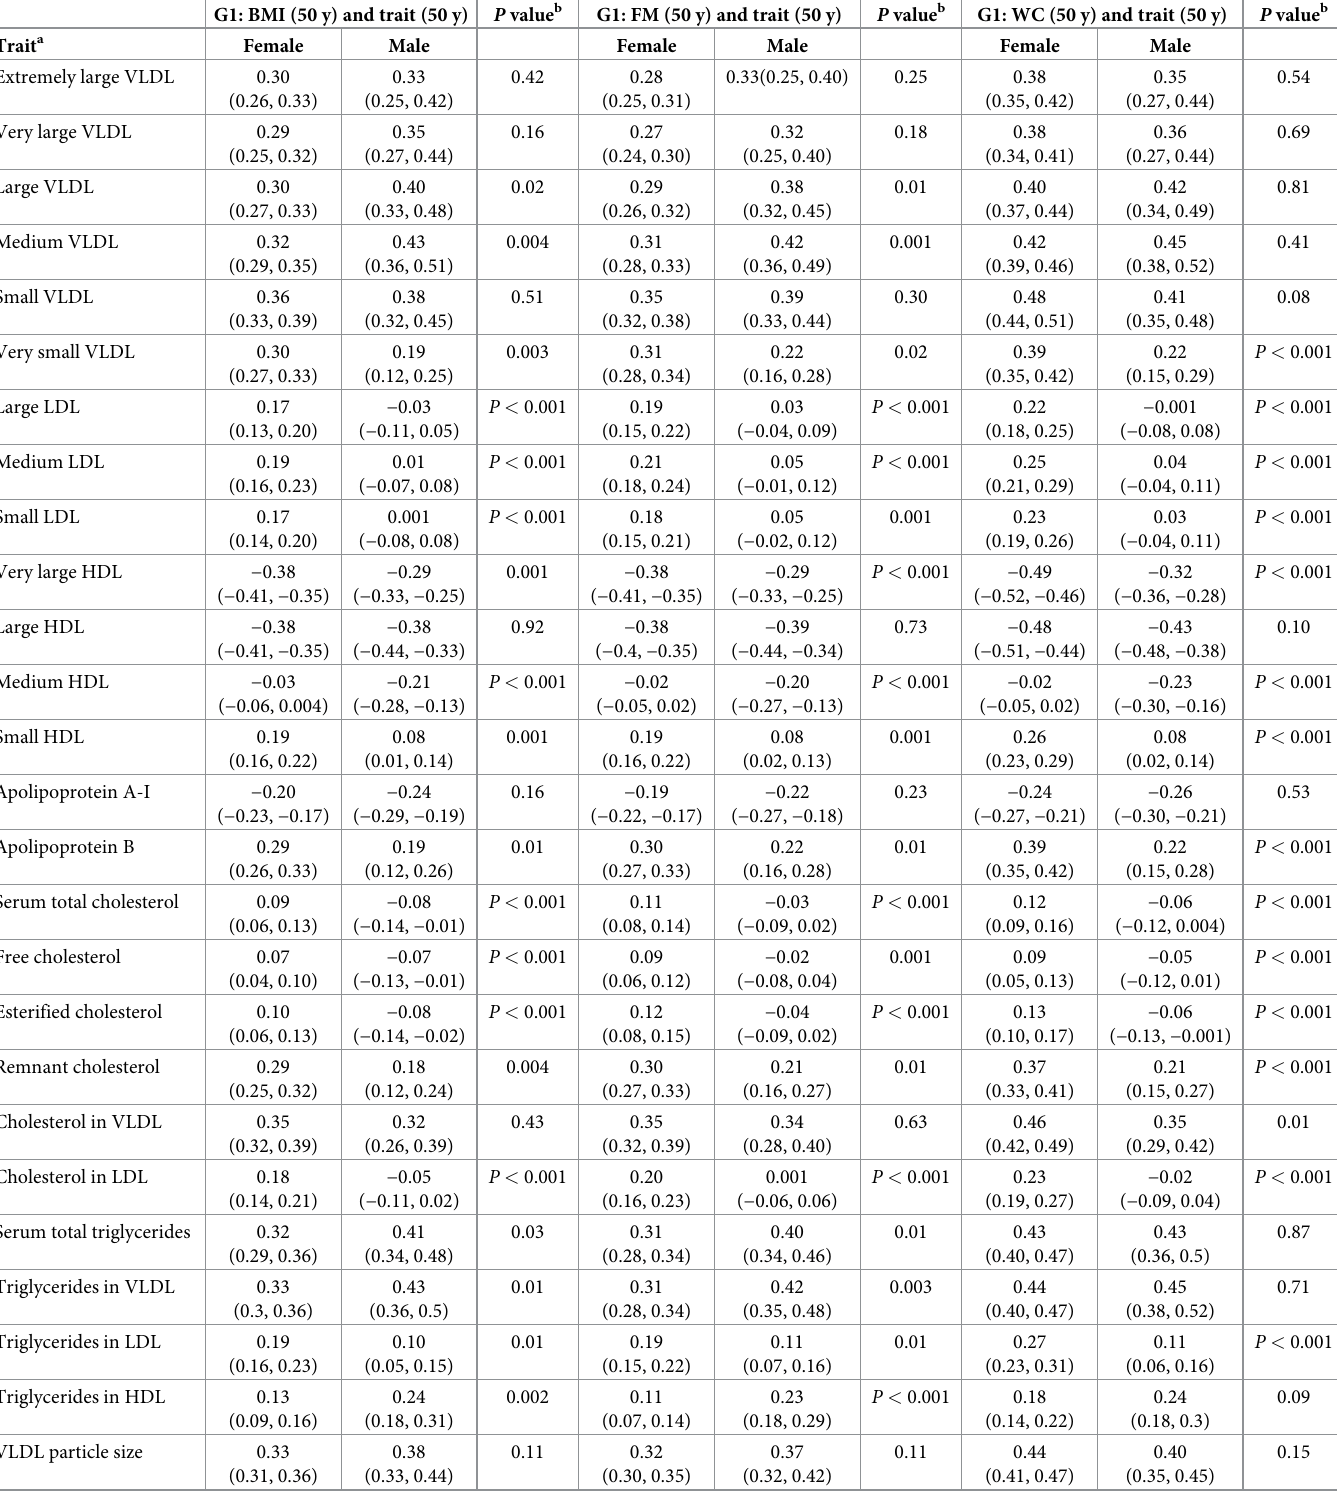
Table 5. Adjusted sex-specific associations of adiposity measures (per SD increase) at 50 y with standardised lipoprotein, cholesterol, triglyceride, and other trait concentrations at 50